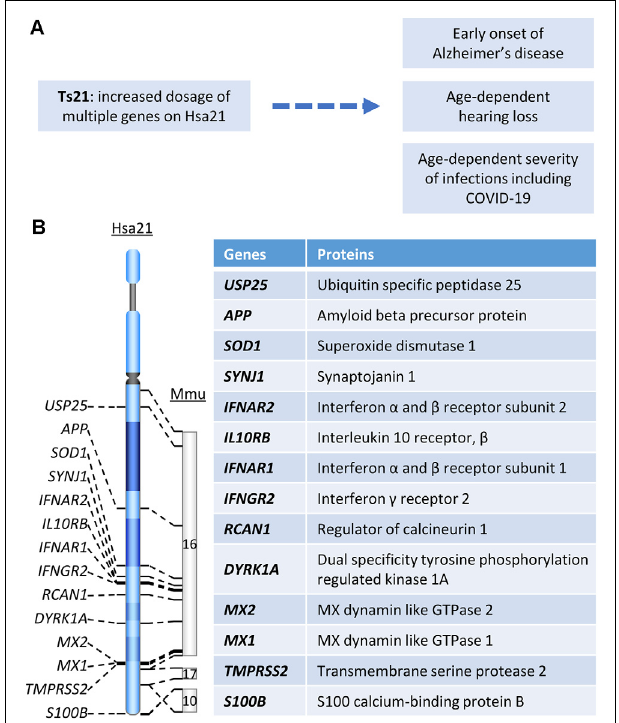
FIGURE 1 | (A) The relationship between Hsa21 and age-related clinical phenotypes. (B) Hsa21 gene orthologs which play important roles in Down syndrome (DS)-associated dementia and other age-related clinical phenotypes.